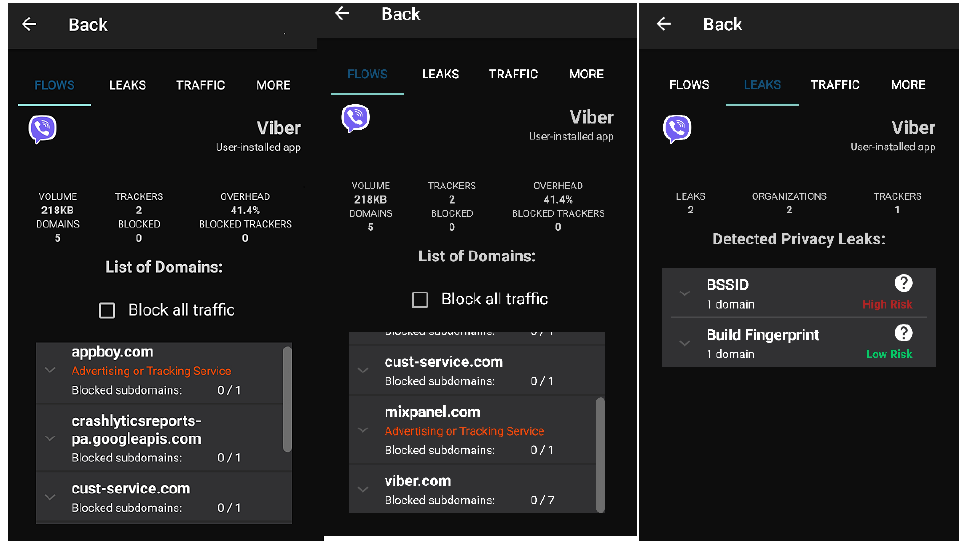
Figure 1. Data flow to ATS from Viber. Table 3. Captured traffic from video conferencing apps to ATS (where “ × ” indicates that traffic to the relevant domain has been captured).